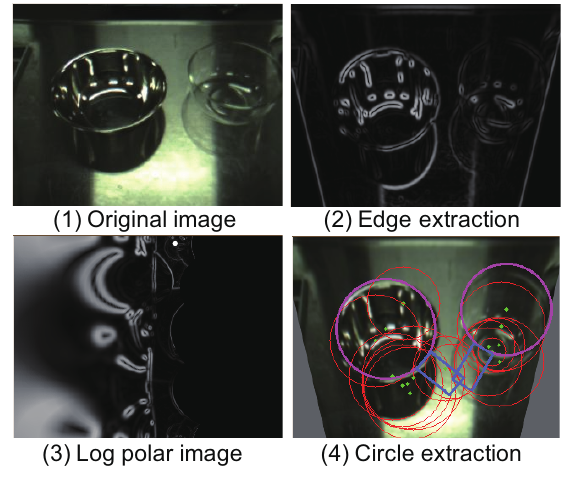
Figure 4. Round container recognition with Hough